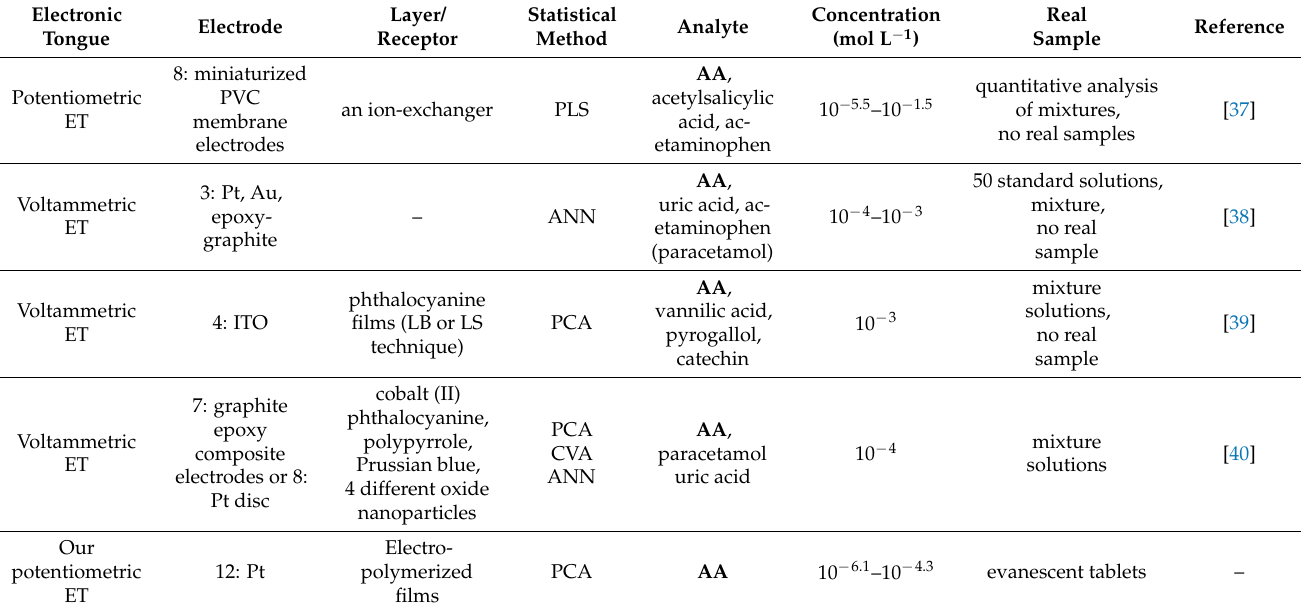
Table 5. Summarization of others electronic tongue sensors for AA